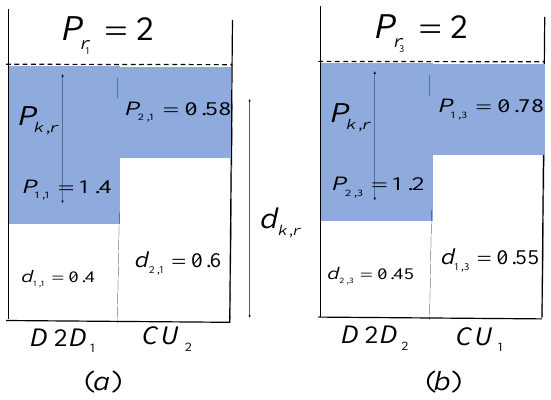
Figure 4. The results of the power allocation of RB 1 and RB 3 which utilizes the NOMA-SIC based